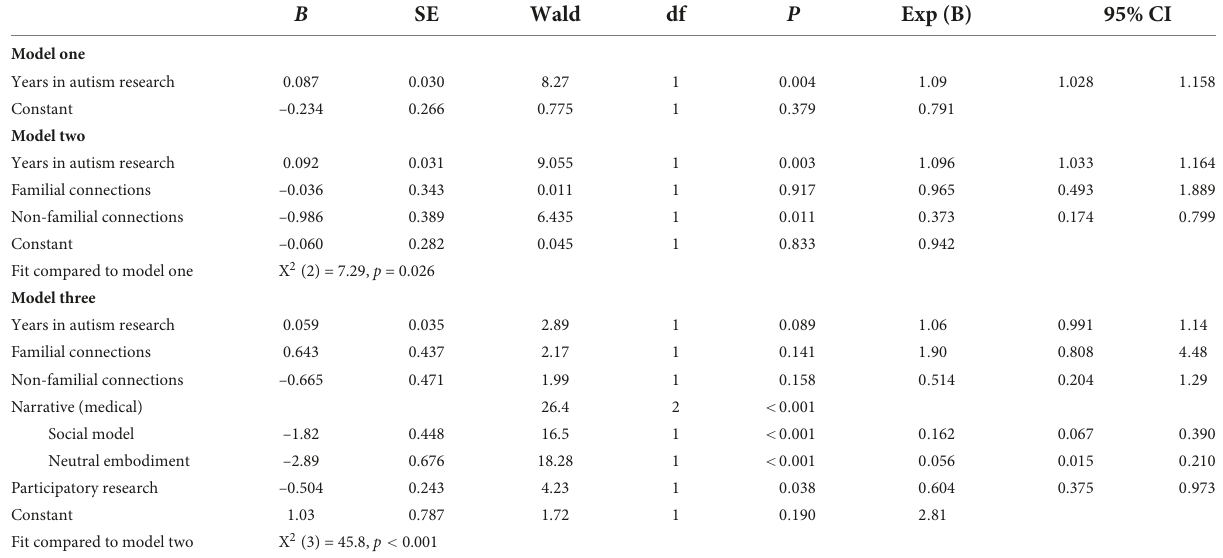
TABLE 6 Binary logistic regression results predicting cues of ableism (present or not present). B SE